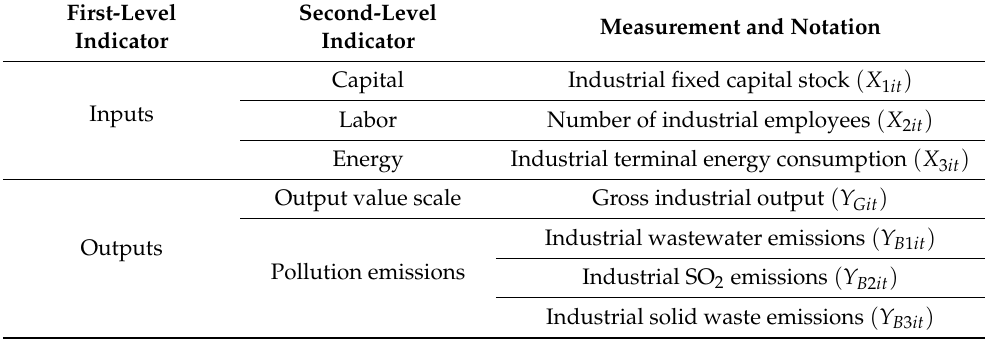
Table 1. Input–output indicator